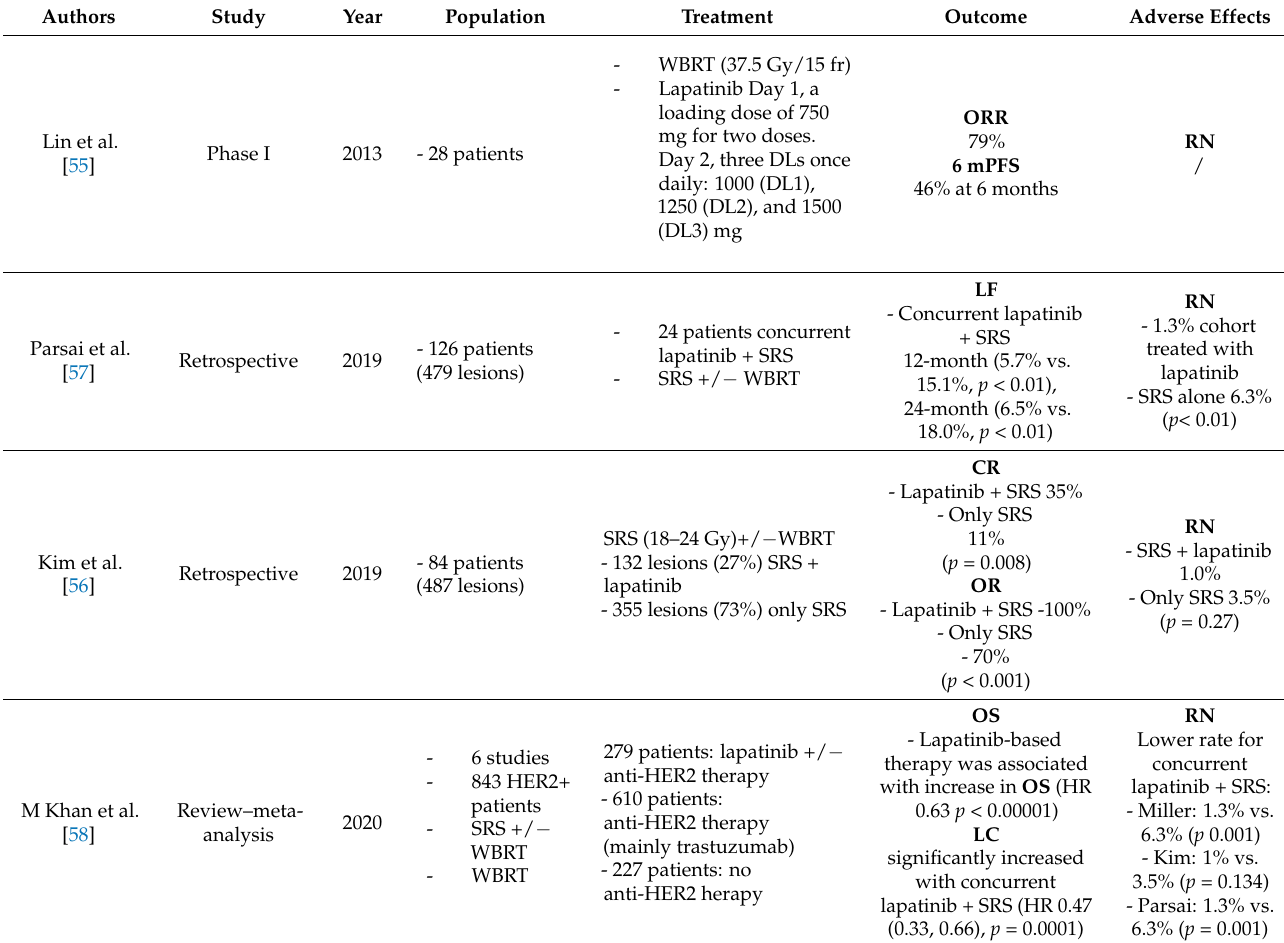
Table 2. Combination of systemic therapy and brain RT: